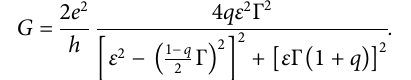
For 0 < q ≤ 1, the two dots are parallel-coupled to the two leads, and q (cid:1) 0 corresponds to the case of the serially coupled con fi guration. Figure 2 presents the results of linear conductance through the double QDs for different values of q . For q (cid:1) 0 and t c (cid:1) 0, the system is an open circuit and the conductance is zero ( G (cid:1) 0 ) as indicated by the solid black line in Figure 2A . For 0 < q < 1, the two dots are connected in parallel con fi guration with asymmetrical left-right couplings, and the analytical expression of the linear conductance is Refs. 28 and 31